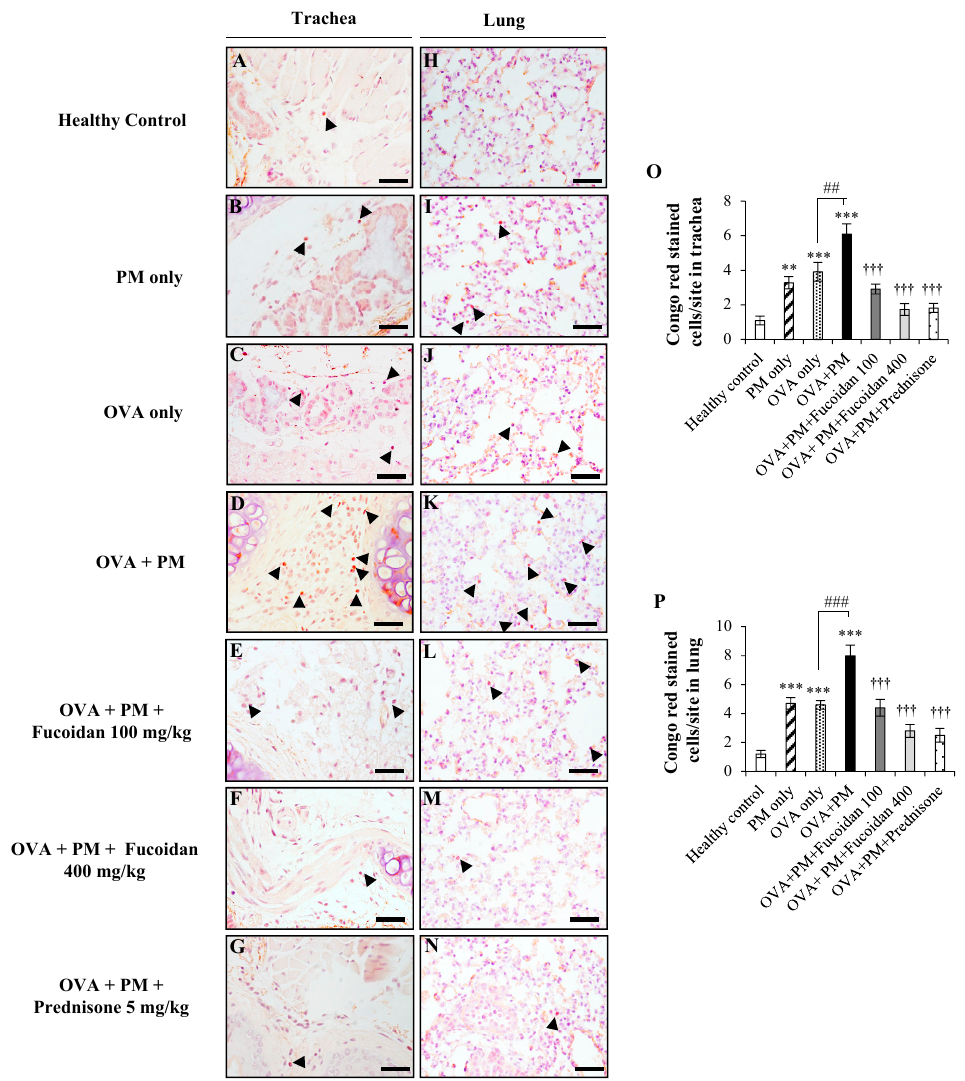
Figure 4. Congo red staining of the trachea ( A – G ) and lungs ( H – N ). ( A , H ) Healthy control, ( B , I ) PM only, ( C , J ) OVA only, ( D , K ) OVA + PM, ( E , L ) OVA + PM + Fucoidans (100 mg / Kg), ( F , M ) OVA + PM + Fucoidans (400 mg / Kg), ( G , N ) OVA + PM + Prednisone (5 mg / Kg). ( O ) Number of Congo red stained cells per site in the trachea, ( P ) Number of Congo red stained cells per site in the lungs. Values are expressed as means ± SEM ( n = 3). ** ( p < 0.005), *** ( p < 0.0005) represent significant increases compared with the healthy control, and ††† ( p < 0.0005) represents a significant decrease compared with the OVA + PM group. ## ( p < 0.005), ### ( p < 0.0005) represents a significant increase compared with the OVA only group. The scale bar of ( A – N ) is 25 µ